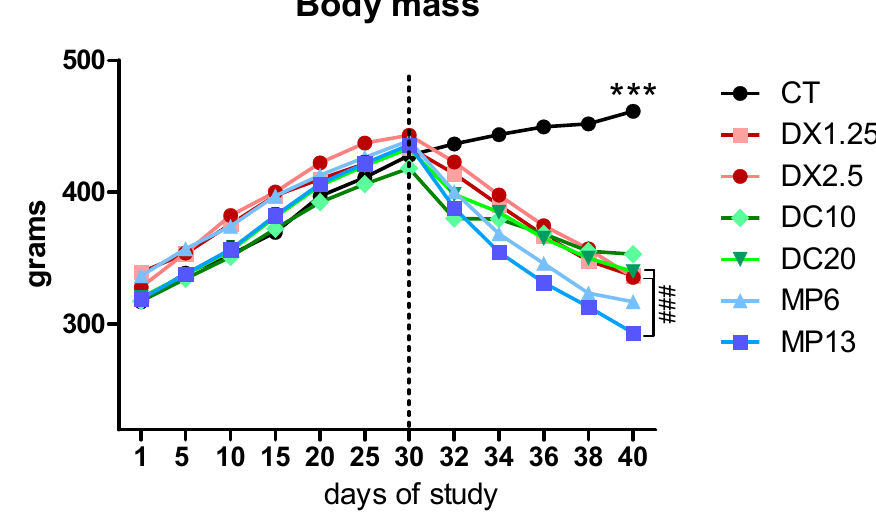
Figure 1. Body mass during the study. The dotted line represents the initial moment of glucocorticoid administration. Asterisks represent statistical difference between the control groups (CT) vs. all groups (#) represent statistical difference between groups. Data are presented as mean. *** or ### = P < 0.001.